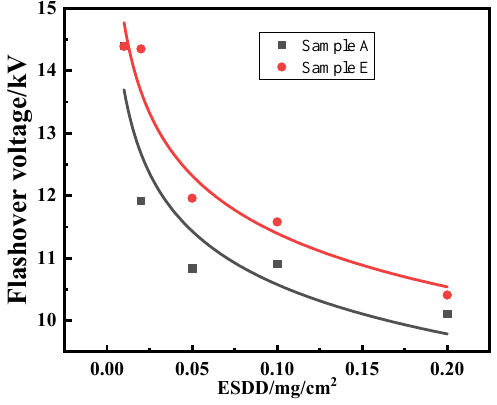
Figure 5. Flashover characteristics of the bushing and the post insulator under different equivalent salt deposit densities (ESDDs).